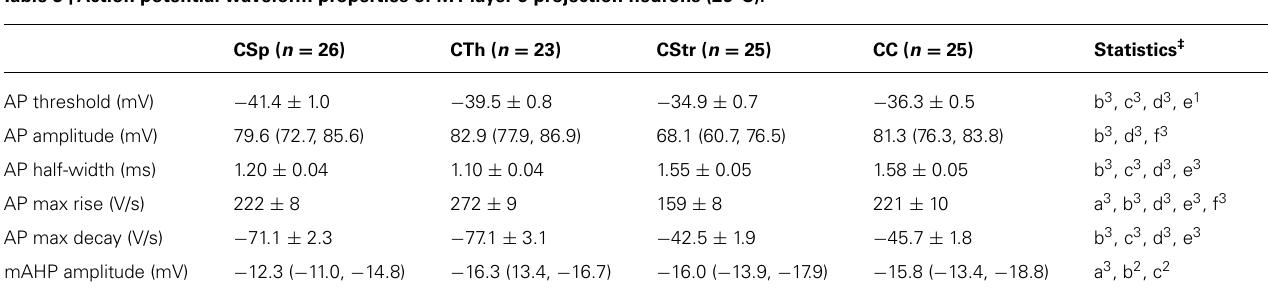
‡ As for Table 1 . (cid:4) Sag potential of hyperpolarisation and cyclic nucleotide-activated current, normalized to peak potential. § Normalized data (absolute values of the natural Log of the adaptation index after adding a constant of 0.025 to each index to remove negative data values).